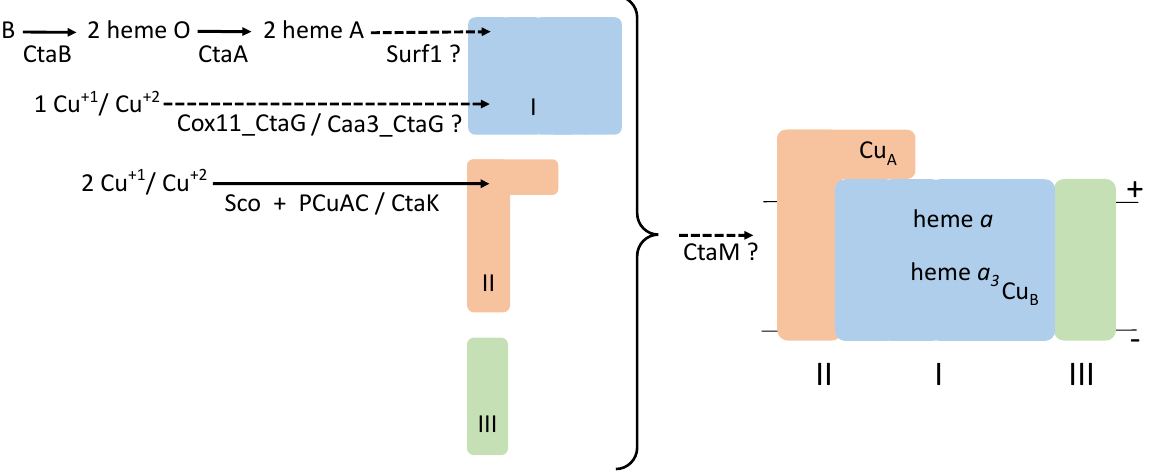
Figure 1. Scheme of cytochrome c oxidase biosynthesis in bacteria and the roles of proteins involved in assembly of the oxidase. The mature enzyme is illustrated on the right-hand side with the core three oxidase subunits labeled with roman numerals. Dashed arrows indicate assembly steps that are not understood at the mechanistic level. A question mark indicates that the function of the protein in the assembly of the oxidase is not established. The biosynthesis proteins presented in the figure are not all found in a single bacterium. + and – indicate the outer and inner sides of the cytoplasmic membrane.